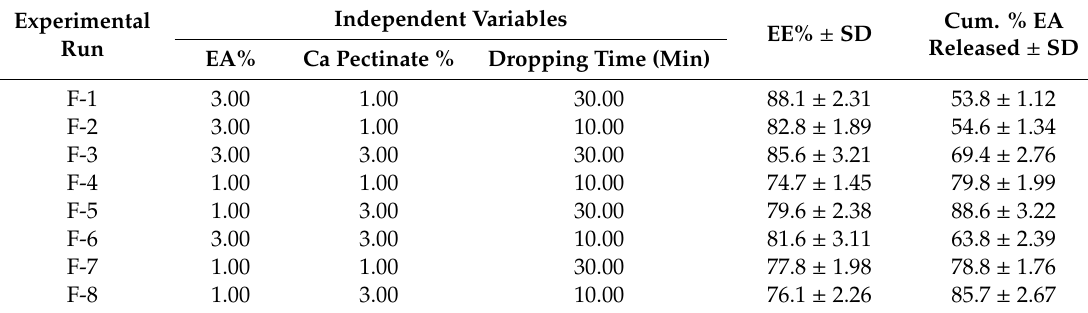
Table 2. Experimental runs and the observed of responses of EA–Ca pectinate beads prepared according to the 2 3 factorial